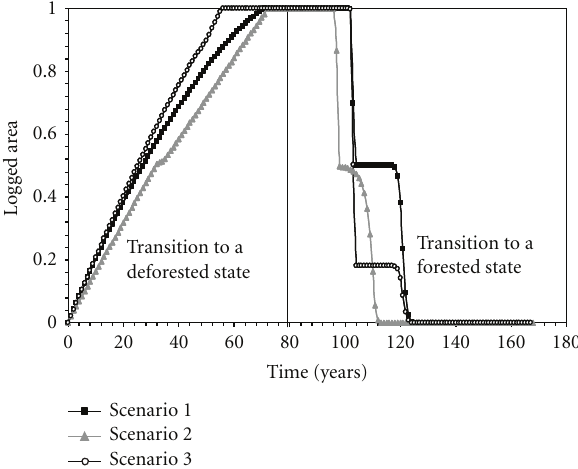
Figure 5: Regime shifts into a deforested state and recovered state in a forest landscape, under three di ff erent scenarios of selective logging and forest management